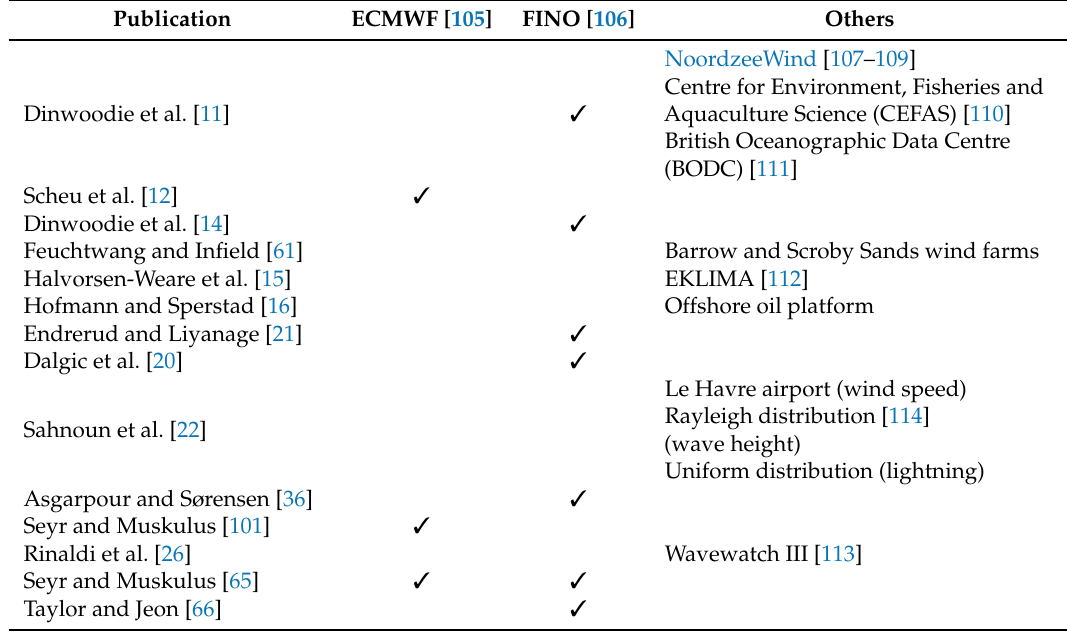
Table 5. This table summarizes which weather data has been used in the different